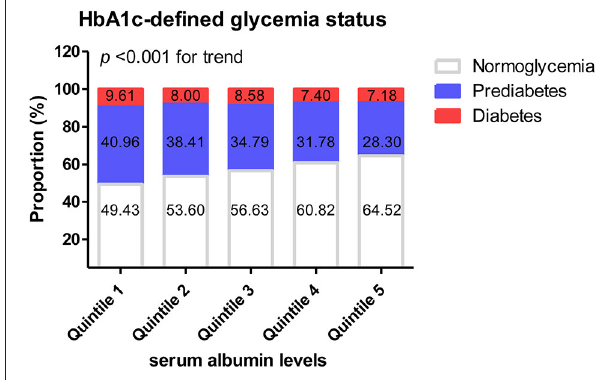
FIGURE 2 | Quintiles of serum albumin levels and HbA1c-defined glycemic